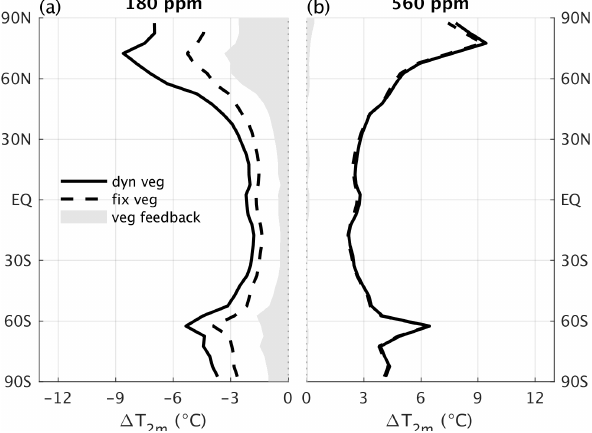
Figure 26. Zonal mean temperature response for atmospheric CO 2 concentrations of (a) 180ppm and (b) 560ppm relative to 280ppm with (solid) and without (dashed) vegetation feedback.